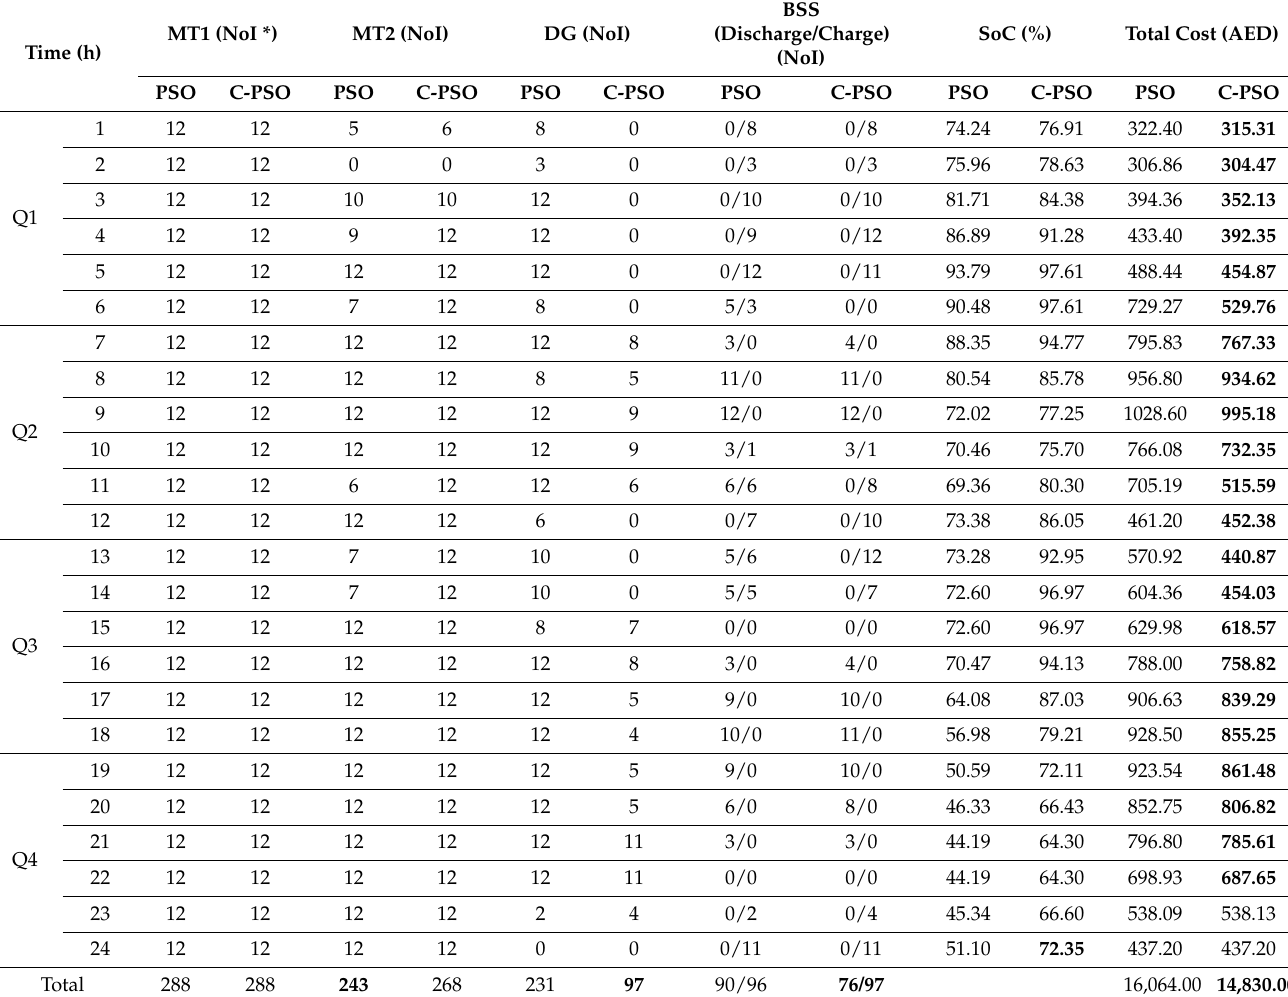
Table 4. Comparative dual-stage dispatch data using PSO and C-PSO on an hourly